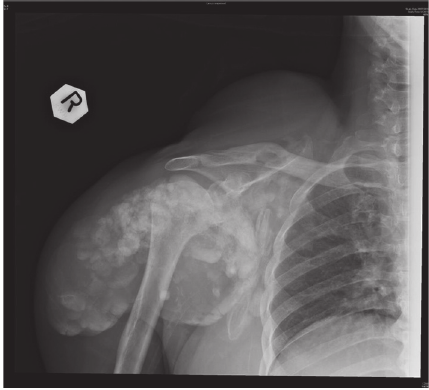
Figure 4: Radiograph of the right shoulder before teriparatide therapy.